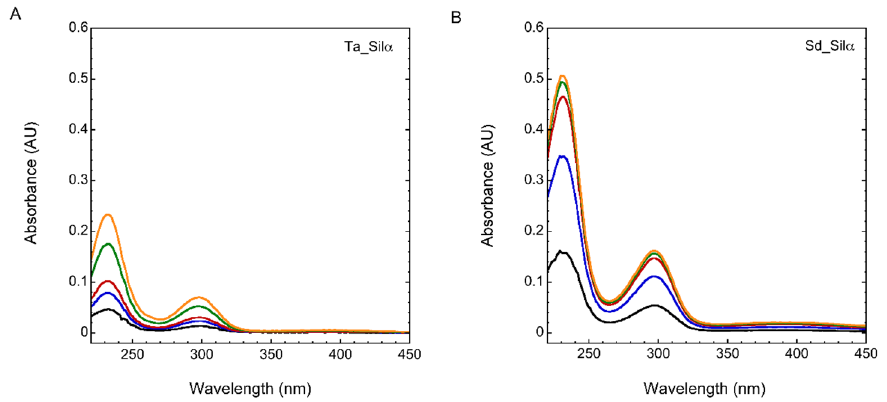
Figure 2. Silyl ether hydrolysis activity of recombinant silicatein- α from Tethya aurantia ( A ) and Suberitis domuncula ( B ). Course change in the absorption spectra upon release of p -aminophenol from the substrate bis( p -aminophenoxy)-dimethylsilane. Black—1 min, blue—2 min, red—3 min, green—4 min, yellow—5 min.